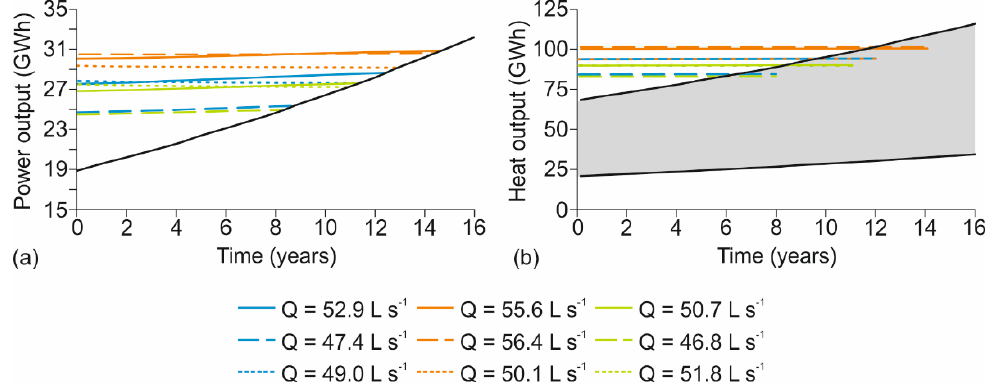
Figure 12. ( a ) Power and ( b ) heating energy produced from the waste heat (color lines) and projected demand (black line and grey polygon). Lower bound of grey polygon—annual heating energy demand estimated based on Yan et al. [14], upper bound of grey polygon—annual heating energy demand estimated based on Gunawan et al. [15]. The reader is referred to Tables 4 and 5 for further details on the flow rates.